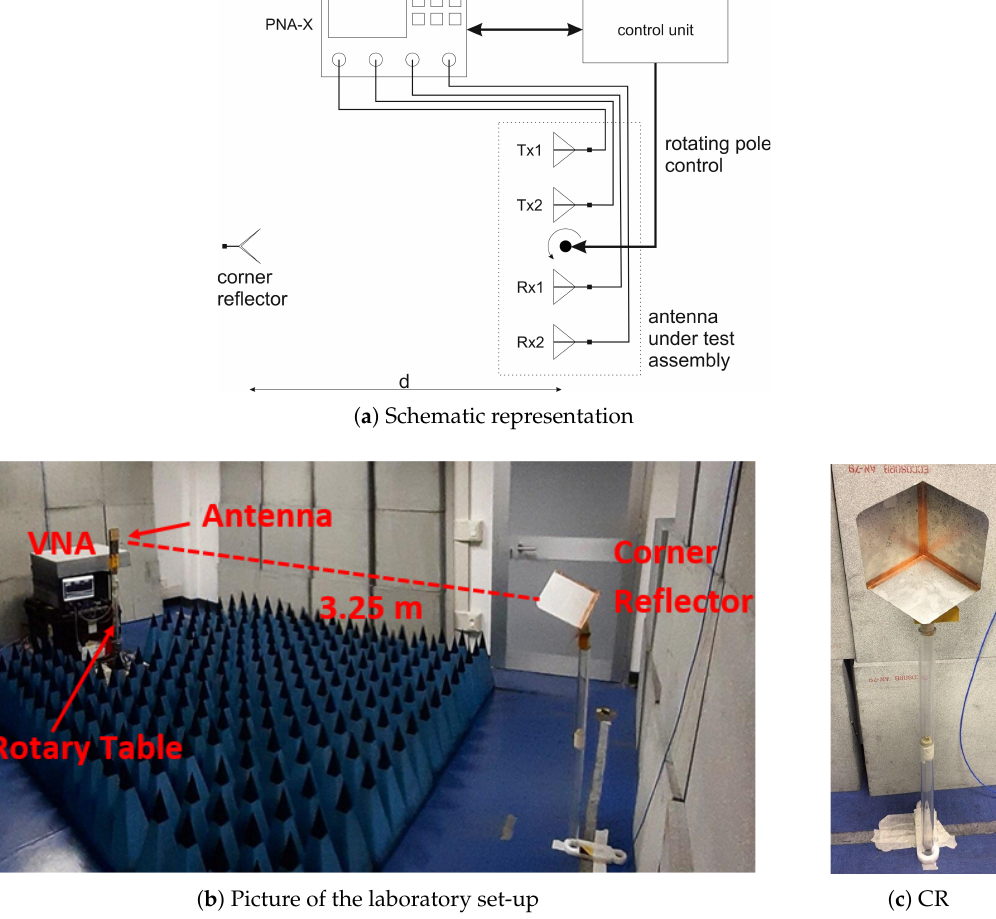
Figure 5. Experimental validation of the antenna sets in the laboratory